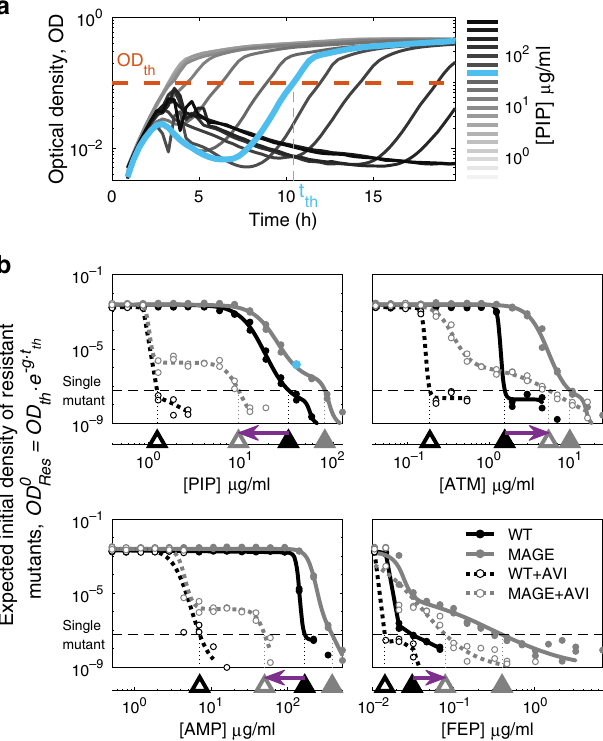
Fig. 2 Combined with avibactam, different drugs differ substantially in the potential for escape mutations. a Growth of the MAGE mutant library on a gradient of PIP concentrations plotted as Optical Density ( OD ) as a function of time. The time t th at which culture density crosses a set OD ¼ 0 : 1). b The initial density of resistant threshold = 0.1 is determined ( OD th mutants OD 0 calculated based on t th and plotted for the WT (black) and Res the MAGE library (grey) on gradients of four beta-lactam antibiotics individually ( fi lled symbols, 40 μ g/ml PIP in cyan corresponds to panel a ) and when supplemented with AVI (no- fi ll symbols). The drug concentration η beyond which the value of OD 0 drops below a density corresponding to Res a single initial mutant is determined (triangles on the bottom axis). The shift in the concentration required to inhibit the mutant library in the presence of AVI, compared to that required for the WT in the absence of AVI, is indicated by a purple arrow. A left-pointing arrow indicates that at the presence of AVI, no single mutant could grow at the drug-only MIC, while a right-pointing arrow is an indication for escape mutants. Source data are provided as a Source Data Fig. 4) indicating that active Bla ampC confers differential